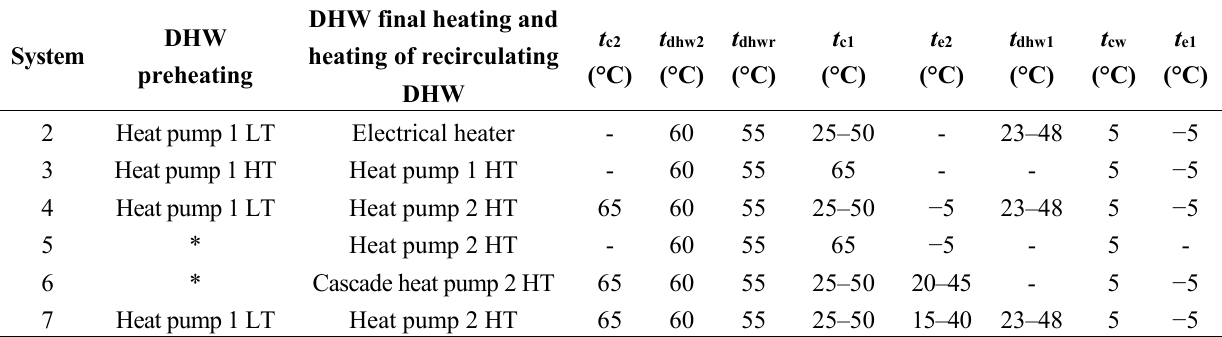
Table 1. System descriptions and temperatures. LT: low temperature; and HT: high temperature.